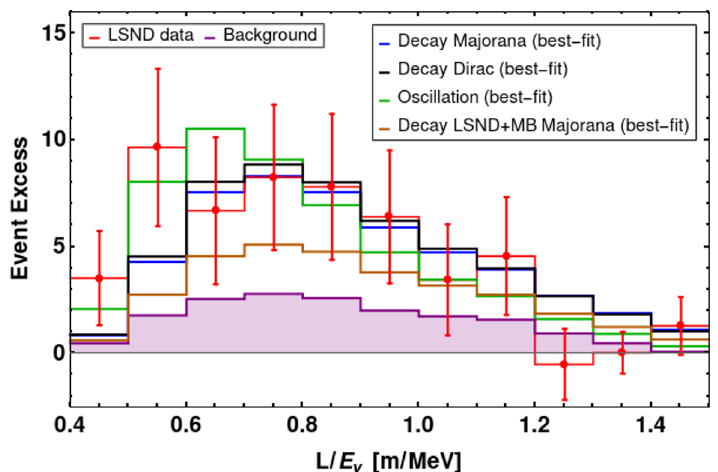
Figure 1 . Best-(cid:12)t (cid:22) (cid:23) e spectra at LSND as a function of L=E (cid:23) for the oscillation hypothesis and for the di(cid:11)erent decaying-sterile-neutrino scenarios discussed here. The data points and the background spectrum are from the LSND collaboration report, presented in ref.